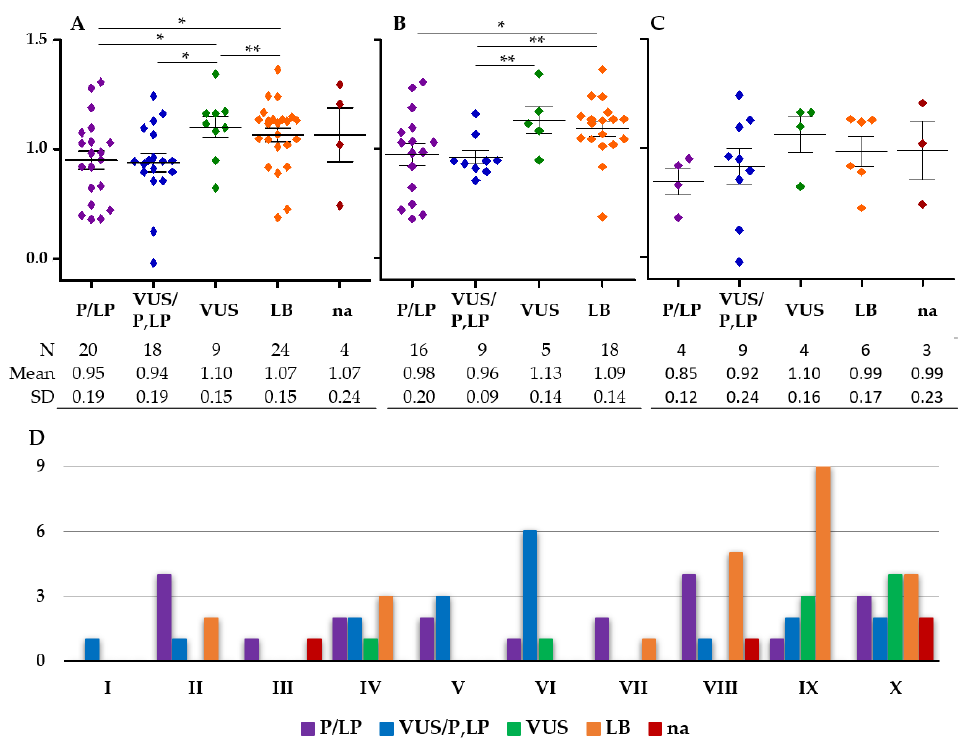
Figure 3 . Weighted polygenic risk score (wPRS) in carriers of APOE variants grouped in different pathogenicity groups. The five pathogenicity groups predicted by Varsome according to the ACMG criterion are: pathogenic/likely pathogenic (P/LP); variant of uncertain significance (VUS); benign/likely benign (B/BL); predicted pathogenicity not available (na). The ADH/FCHL (A), ADH (B), and FCHL (C) cohorts are indicated above their respective plots. (D) Distribution of the variants from the five pathogenicity groups within the wPRS deciles of the Whitehall II control cohort [7]. * p<0.05, ** p<0.005, non-parametric Mann–Whitney test.